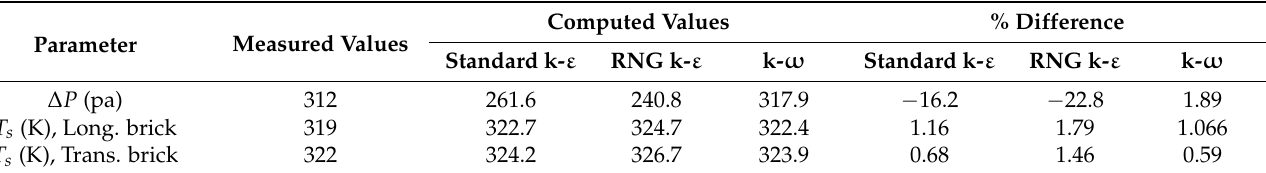
Table 2. The computed pressure drop ( ∆ P ) and surface temperature ( T s ) values of the longitudinal and transverse bricks using the standard k- ε , RNG k- ε , and k- ω turbulence models against the experimental values for the case of